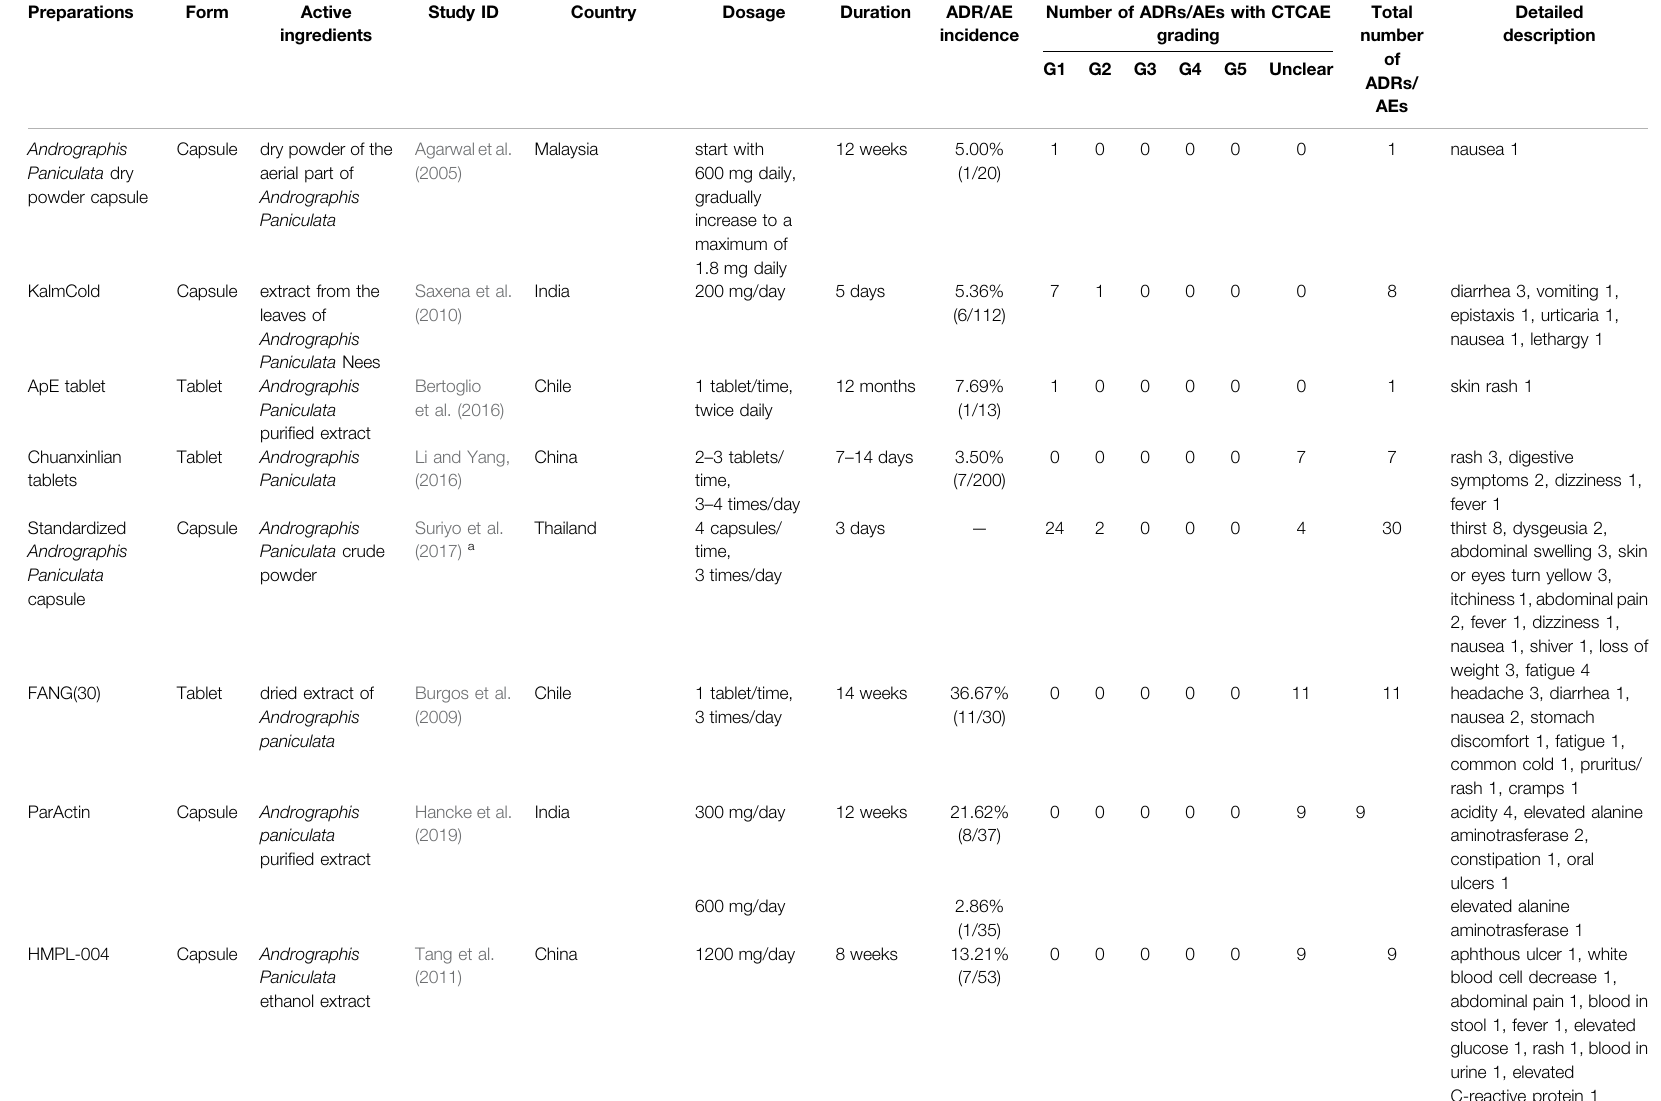
TABLE 6 | Herbal preparations of Andrographis paniculata used in RCTs, non-RCTs, case series and their ADRs/AEs.